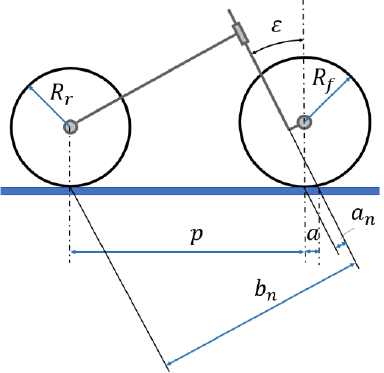
Figure 2. PTW main geometrical and inertial parameters.